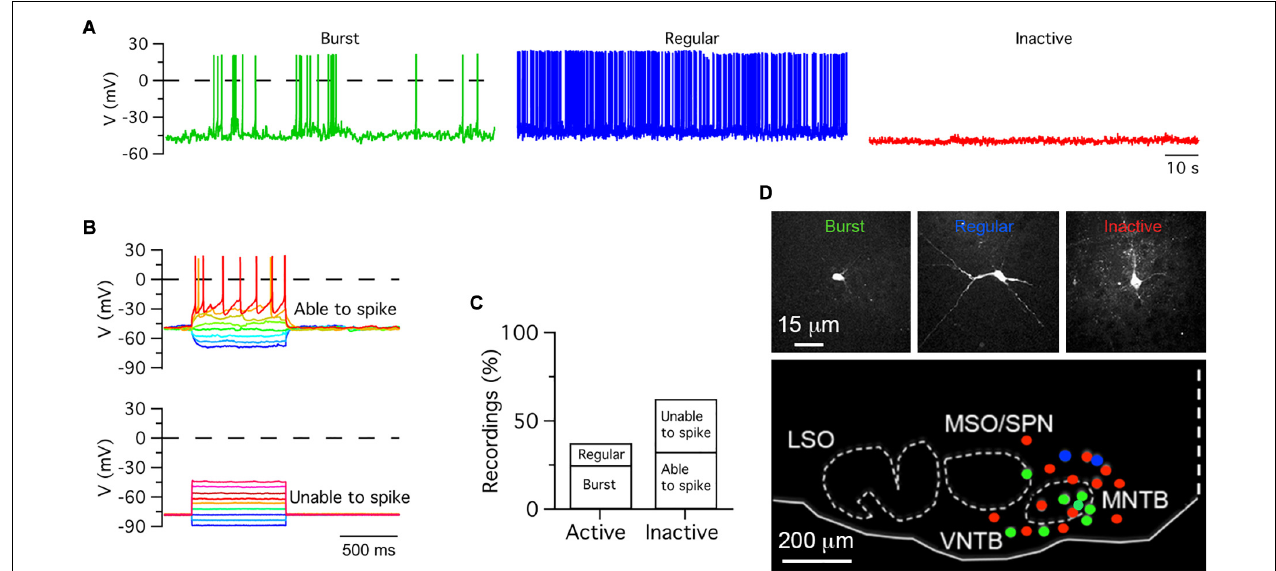
FIGURE 2 | Heterogeneous electrical activity in medial olivocochlear neurons. (A) Exemplar patch-clamp whole cell recordings of burst firing, regular firing and inactive cells obtained from pups anesthetized with 1.5% ISO. (B) Inactive cells were subjected to hyperpolarizing and depolarizing voltage steps. Depolarization steps triggered action potentials in some cells but not in others. (C) Percent of active and inactive cells. (D) Exemplar images of cells shown in (A) (top row). Distribution of recorded cells in the auditory brainstem in neonate pups (bottom). Recording traces were not corrected for the liquid junction potential.